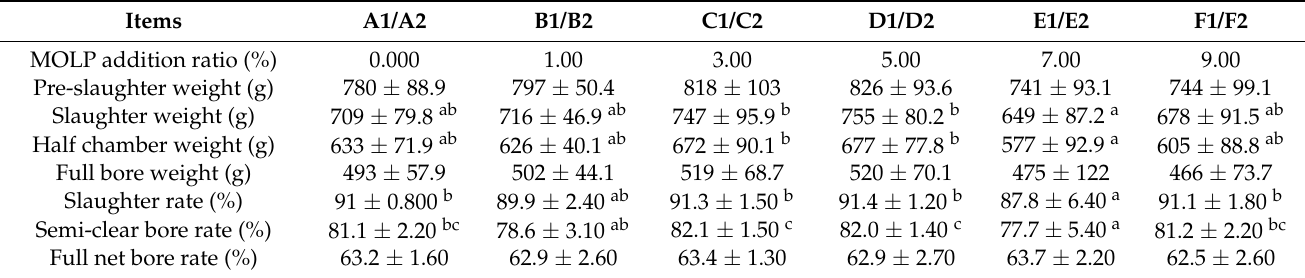
Table 3. Effects of Moringa oleoresin leaf power on the carcass characteristics of broiler chicken fed a 4-week diet.